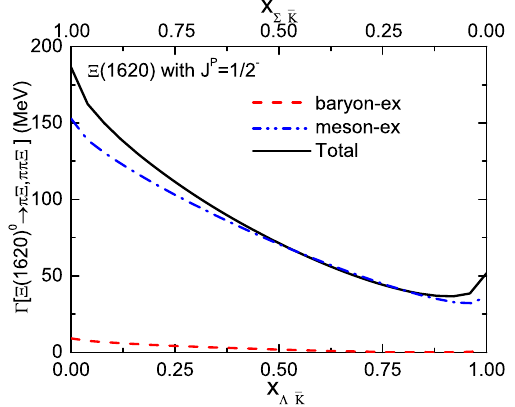
Fig. 6 Decomposed contributions to the decay width of the Ξ( 1620 ) 0 into πΞ and ππΞ as a function of the parameter X ¯